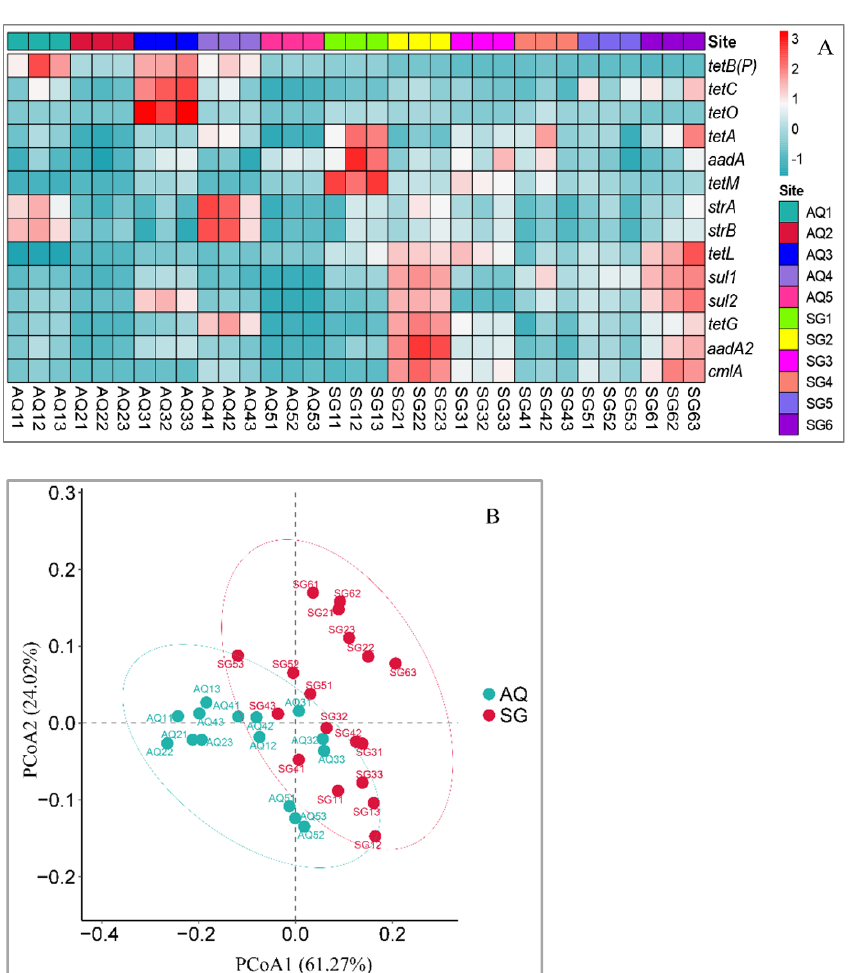
Figure 4. Heatmap ( A ) and PCoA ( B ) based on the Bray–Curtis index of ARGs in different greenhouse soils.